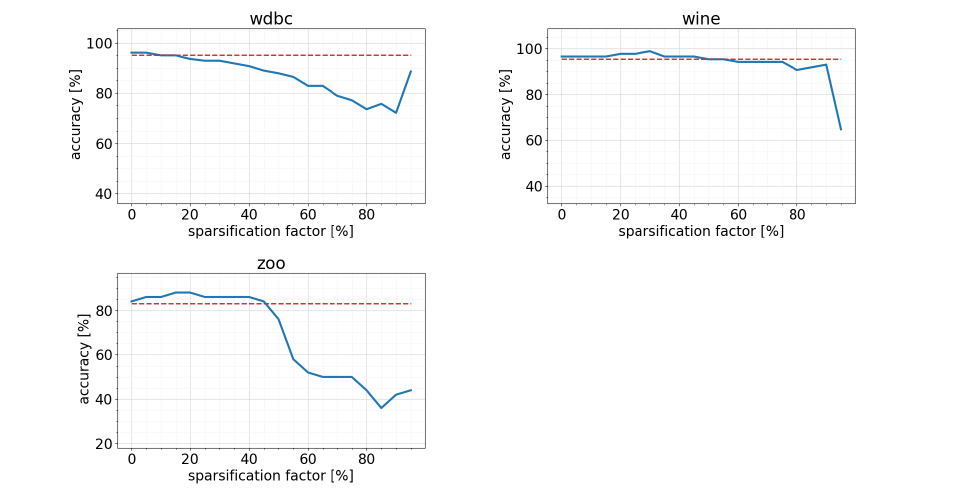
Figure 21. Results of pruning SVM structure on sonar, vehicle, waveform21 and waveform40 datasets.